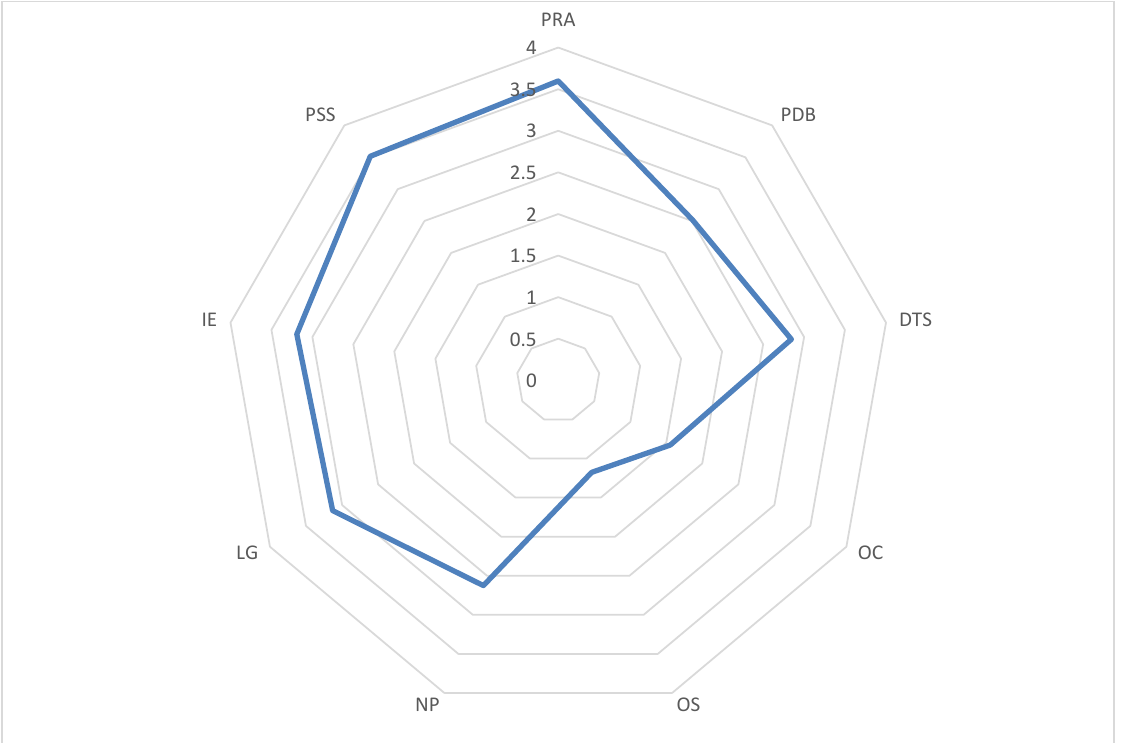
Fig. 4. Graphical ranking of CoCoSo method divided by sensitivity test. Source: Computed by Authors. Created by